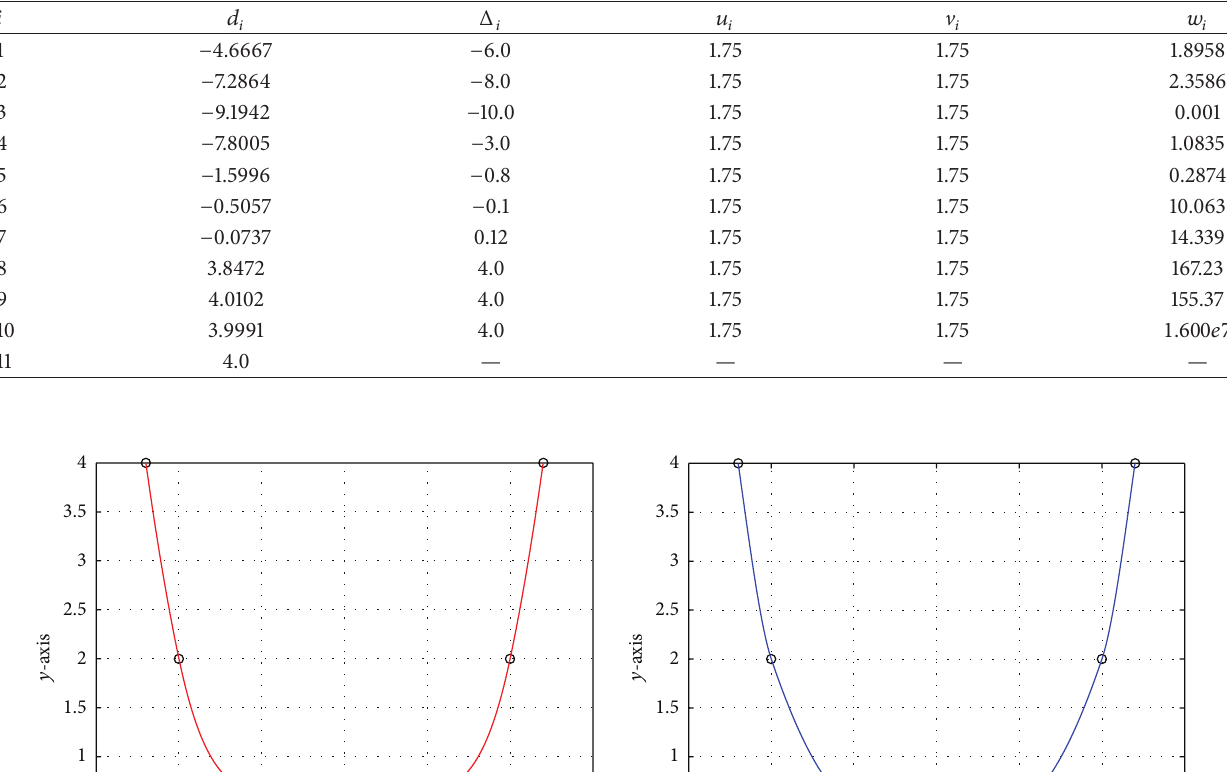
Table 4: Numerical results of Figure 2(d).